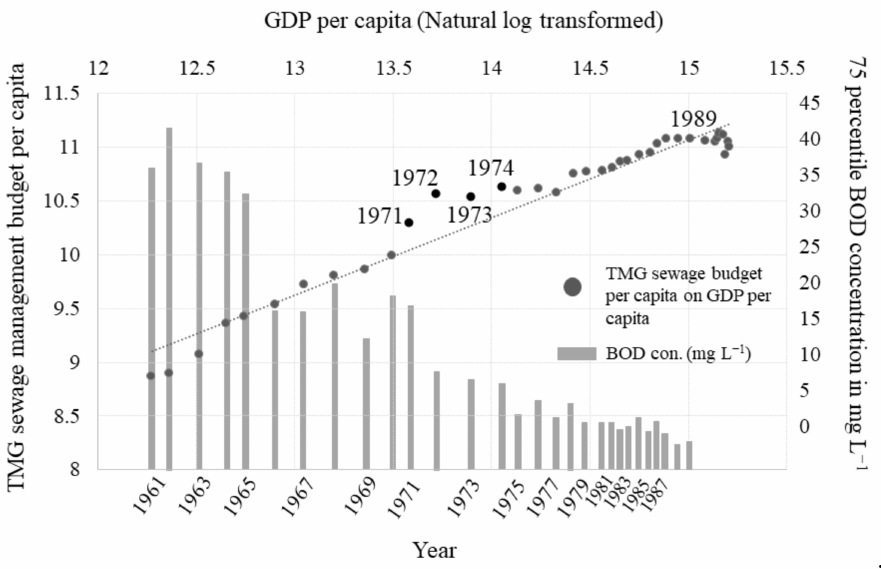
Figure 6. Investment in sewage management and BOD concentration. Regression line: y = 0.72 x + 0.27; R 2 = 0.95.